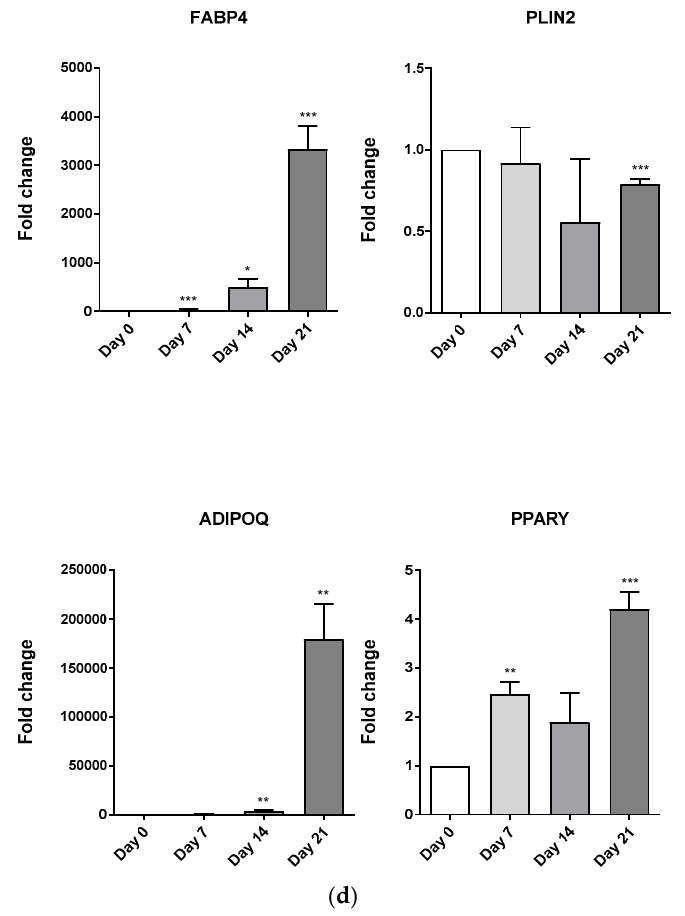
Figure 5. Adipocytic differentiation of C3H10T1/2, hMSC-TERT cell lines. ( a ) Differentiation of C3H10T1/2 along 21 days with lab-made medium. ( b , c ) Oil Red O staining of C3H10T1/2 and hMSC- TERT cells differentiated through 21 days with lab-made medium. ( d ) Differentiation of hMSC-TERT along 21 days with lab-made medium. FABP4, PLIN2, ADIPOQ, and PPAR γ adipogenic marker gene expression assessed by RT-qPCR. Data coming from at least three independent experiments is presented as fold change over D0 differentiation data and expressed as the Mean ± SEM (* p < 0.05; ** p < 0.01; *** p < 0.001; .).